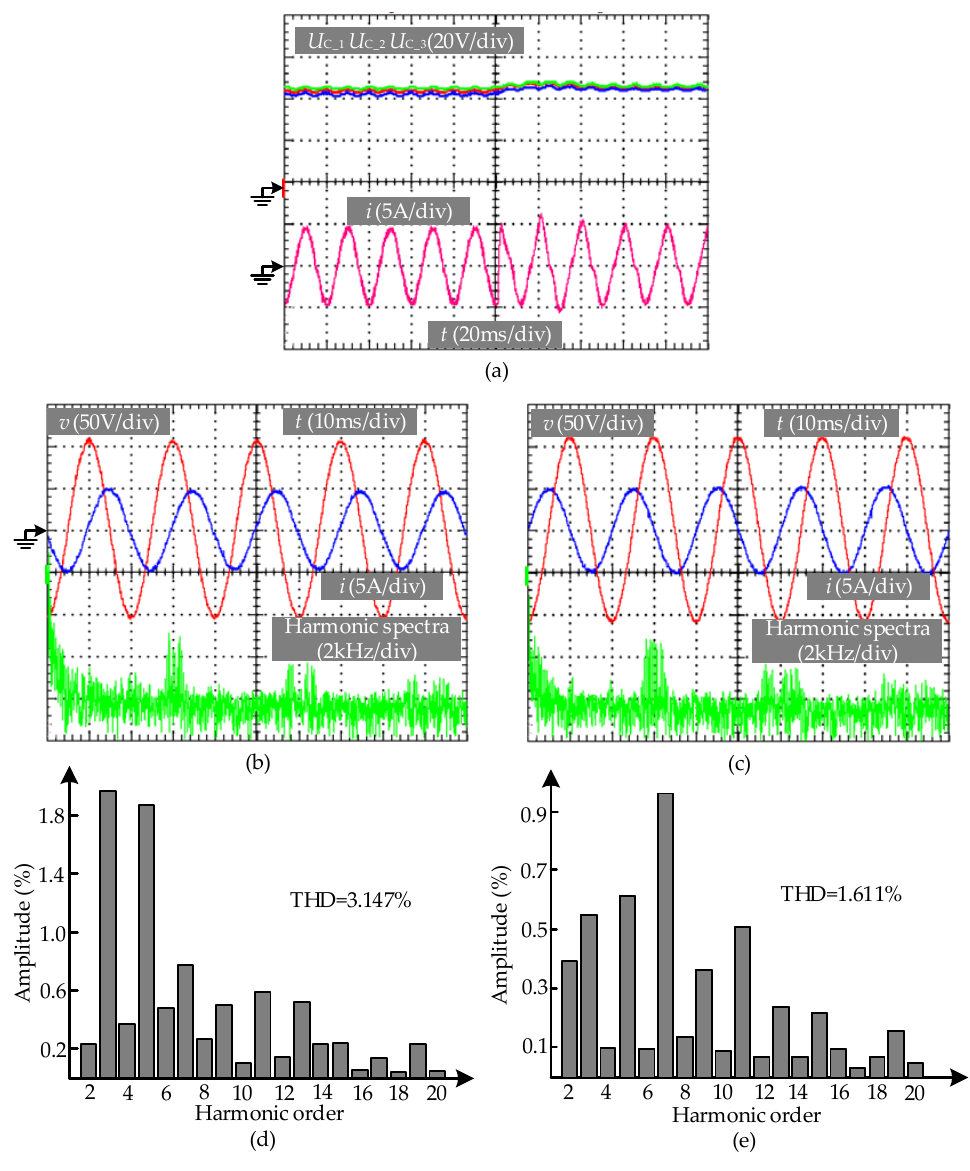
Figure 16. Steady-state experimental waveforms of capacitor voltages, grid voltage, and compensating current. ( a ). Capacitor voltages and compensating currents from inductive to capacitive mode. ( b ) Grid voltage, compensating current, and its harmonic distribution in the inductive mode. ( c ) Grid voltage, compensating current, and its harmonic distribution in the capacitive mode. ( d ) Fourier analysis of compensating current in the inductive mode. ( e ) Fourier analysis of the compensating current in the capacitive